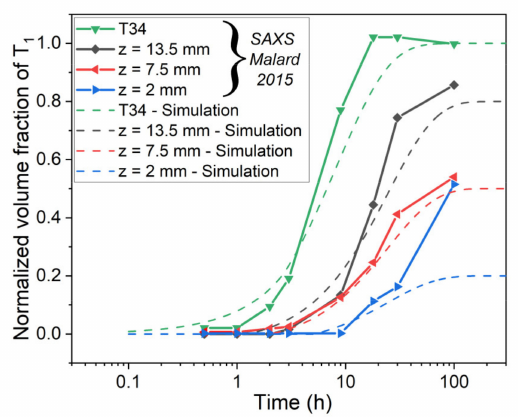
Figure 14. The experimental and simulated evolutions of the normalized volume fraction of the T 1 precipitates in the nugget at the weld center during post-weld heat treatment at 155 ◦ C. The revised model is used for the simulations. Experimental data comes from Malard et al. [6].